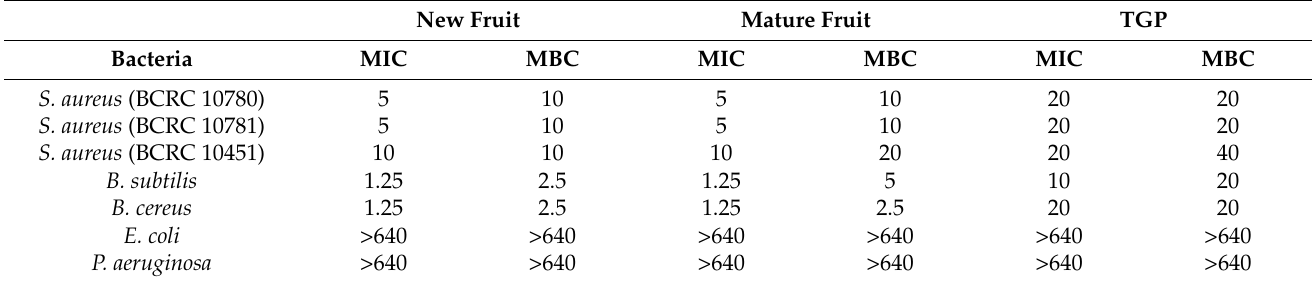
Table 2. MIC and MBC ( µ g/mL) of TGP extract and the surface material of M. tanarius fruit. New Fruit Mature Fruit TGP New Fruit